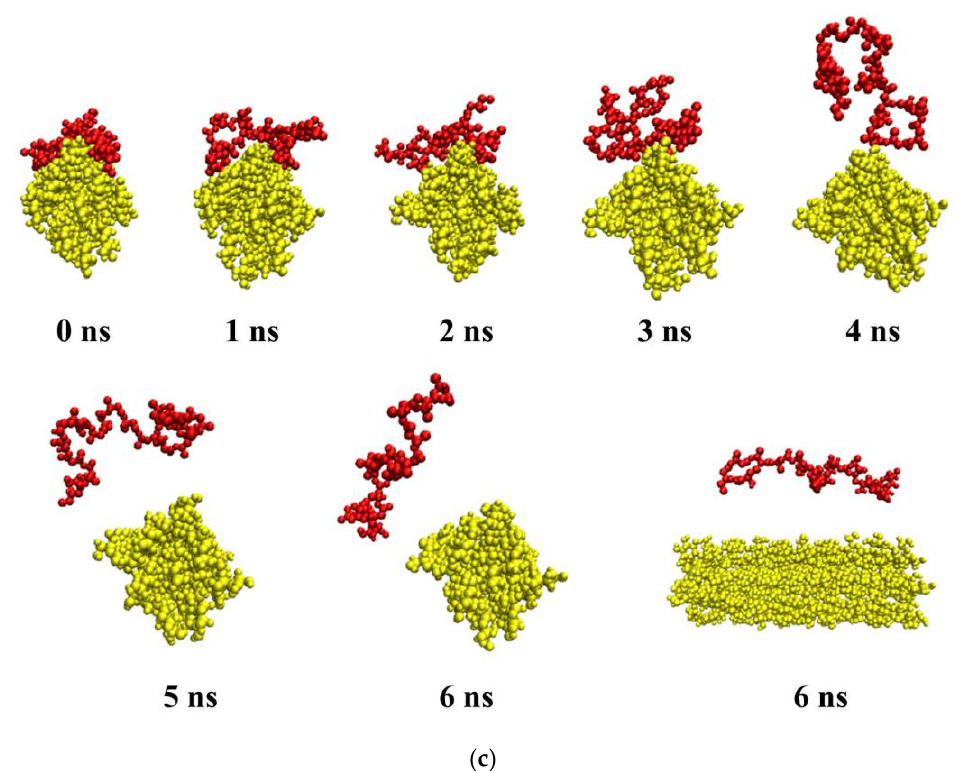
Figure 16. Time dependence of the number of contacts ( a ) and PHBV–CNC hydrogen bonds ( b ); instant snapshots of mutual arrangement of PHBV and CNC in time ( c ) (DCM molecules are not shown for clarity).